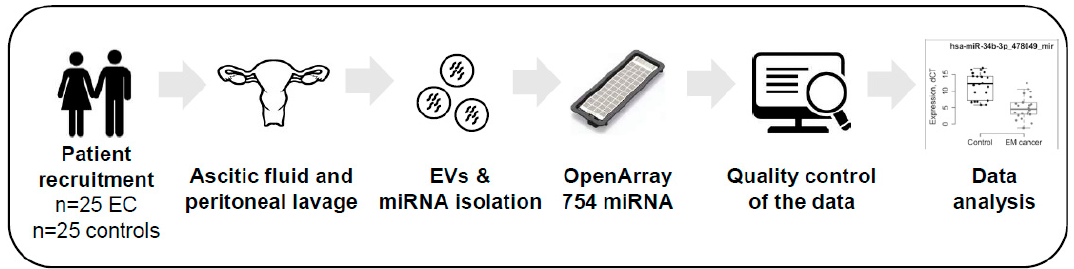
Figure 1. Workflow of the study design. Abbreviations: EC, Endometrial Cancer; EVs, Extracellular vesicles.